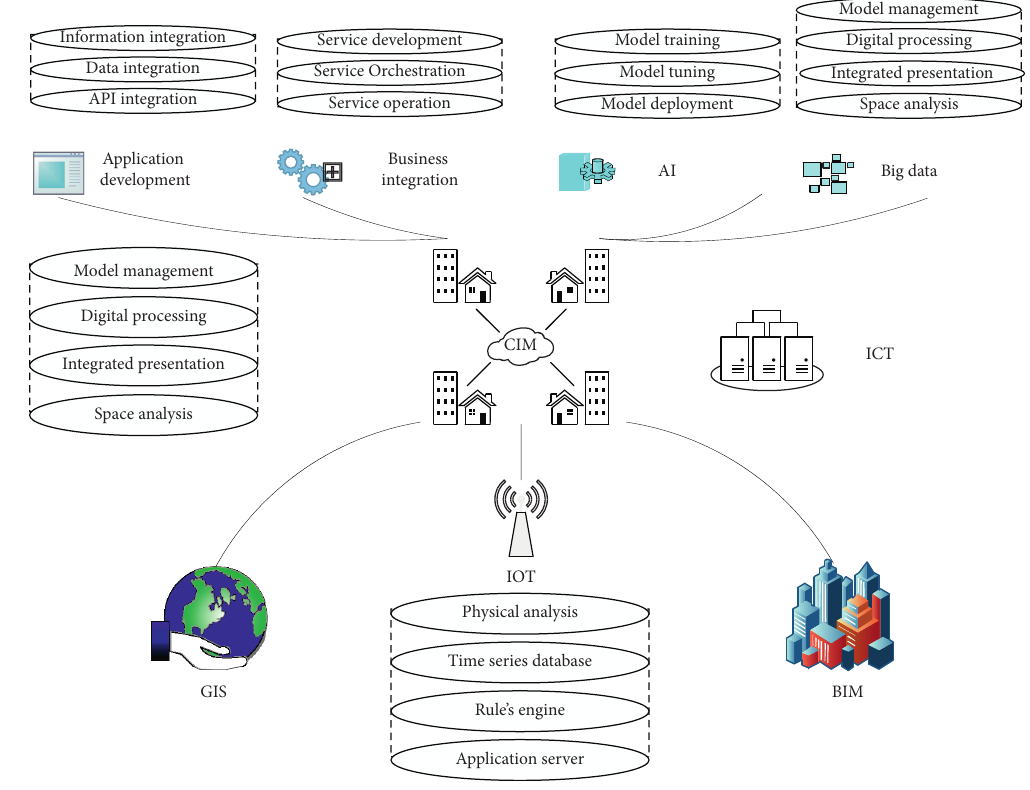
Figure 4: The structure of the platform support